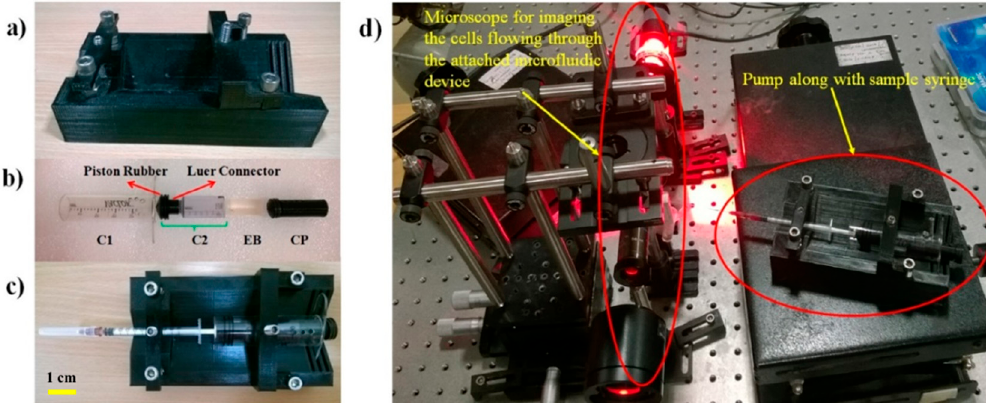
Figure 4. Prototype of the parts used in making the pump and characterization experimental set-up.